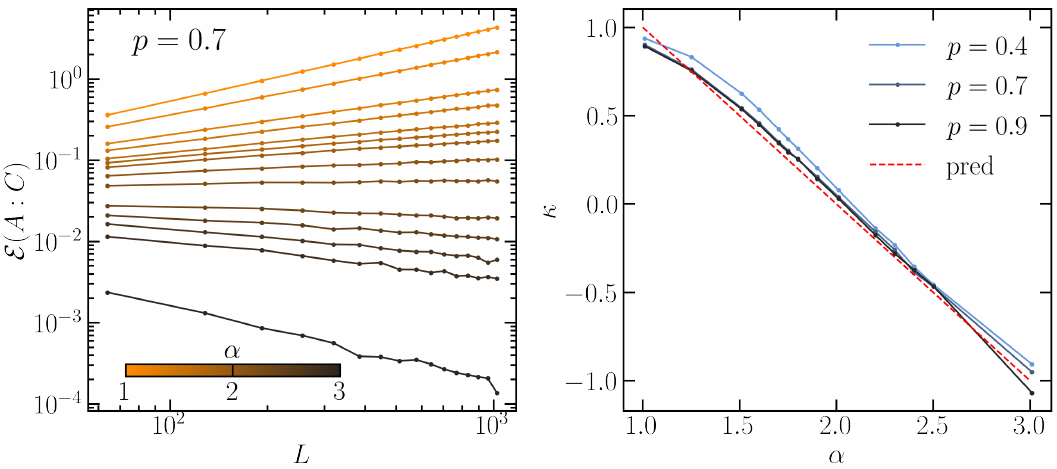
Figure 8: Scaling of the entanglement entropy for various interaction range α and various measurement rate p . We clearly see an algebraic scaling S ( L / 2 ) ∝ L µ , with µ = 1 signaling a volume law and µ < 1 an algebraic law.